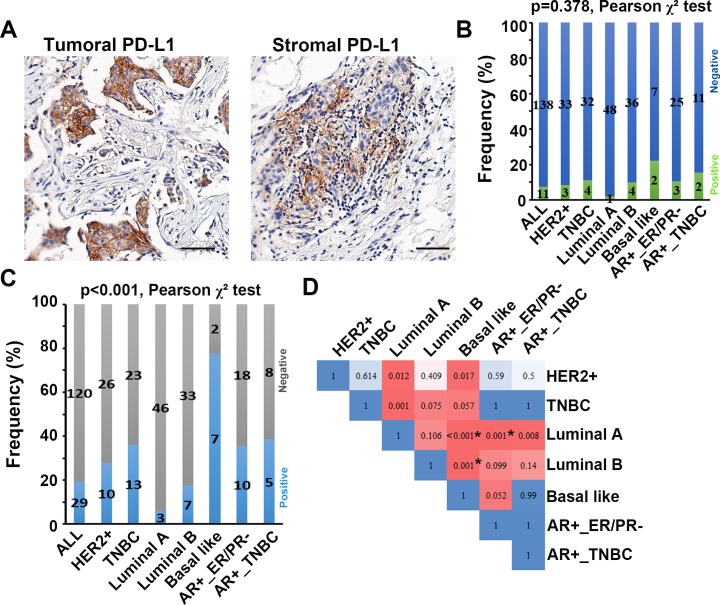
Tumoral and stromal expression of PD-L1.(A) Representative image of positive tumoral and stromal expression of PD-L1. Scale bar: 50 μm. (B, C) Distributions of tumoral(B) and stromal(C) PD-L1 expression status in different molecular subtypes of breast cancer. The number in the histogram bar indicated the number of cases. Multiple comparison among different molecular subtypes was performed by Pearson χ2 test. (D) Differences between each other of stromal PD-L1 expression status among seven molecular subtypes indicated by p values. The comparison between each molecular subtype was conducted by Pearson χ2 test and corrected by Bonferroni correction. Because of 21 comparisons between each other among seven molecular subtypes, differences were considered significant when the Bonferroni correction p value less than 0.0024 (0.05/21).